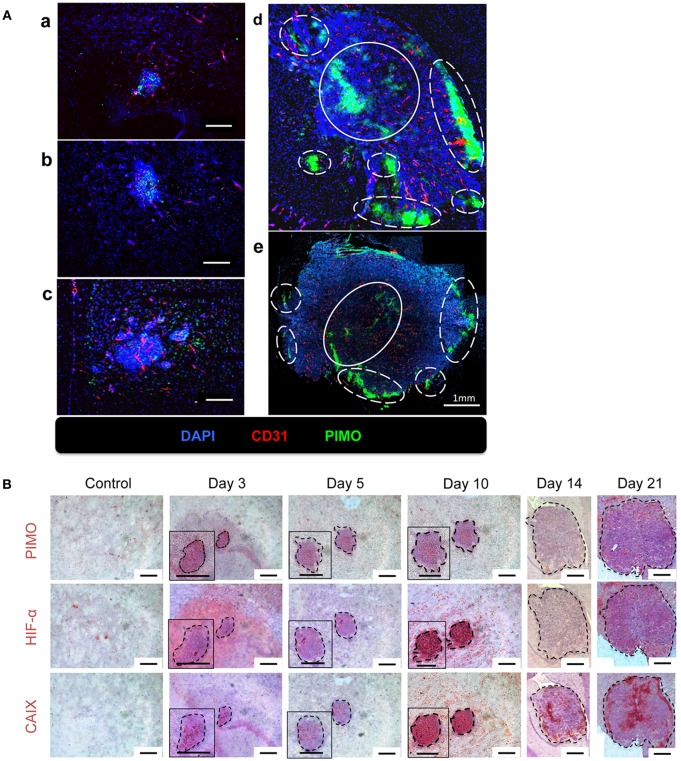
The temporal and spatial pattern of tumor hypoxia-associated markers during tumor progression. (A) Mice were sacrificed on day 3 (a), day 5 (b), day 10 (c), day 14 (d), and day 21 (e) after I.C. inoculation of ALTS1C1 tumors. Tumors were double staining for CD31 (red) and hypoxia marker PIMO (green). Nucleus was stained by DAPI (blue). The peripheral hypoxia was marked with white dotted line and the central hypoxia was marked by white solid line. (B) Representative figures for hypoxia-associated markers, PIMO (brown), HIF1-α (brown), and CAIX (brown) on normal brain tissue (control) and ALTS1C1 tumor tissue. Nucleus was visualized by staining with hematoxylin (blue) and tumor was outlined by black dotted line. Scale bar = 200 μm.